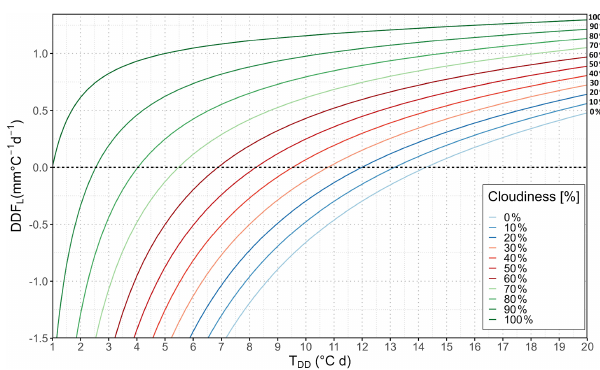
Figure 6. Longwave radiation component (DDF L ) for selected cloudiness (%) and degree days ( ◦ Cd).